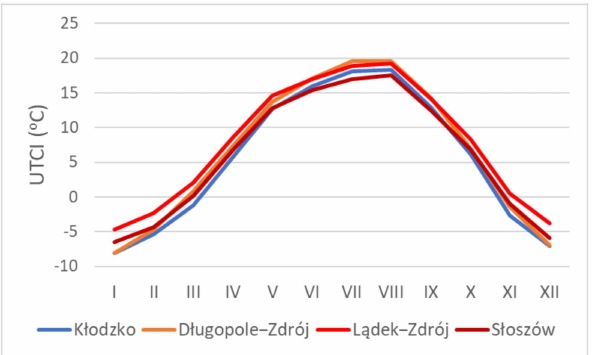
Figure 3. Mean monthly values of UTCI in 1971–2010 in Kłodzko Land, based on 12:00 UTC data.